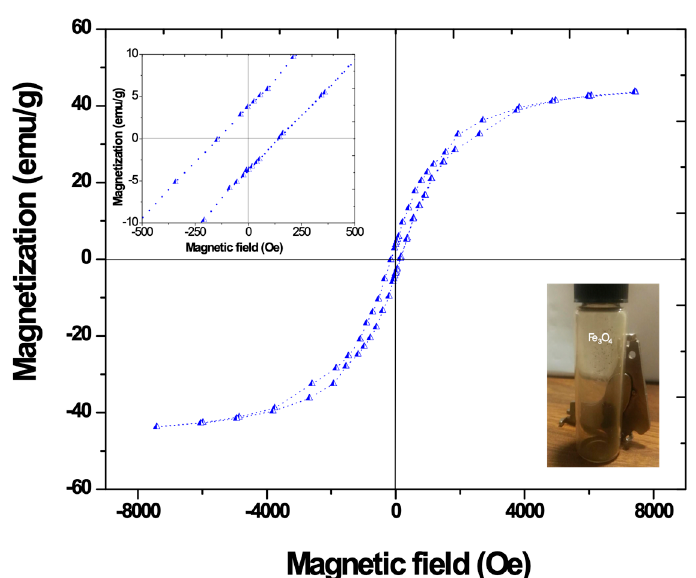
Figure 6. Magnetic hysteresis loop of the Fe 3 O 4 NPs at room temperature.